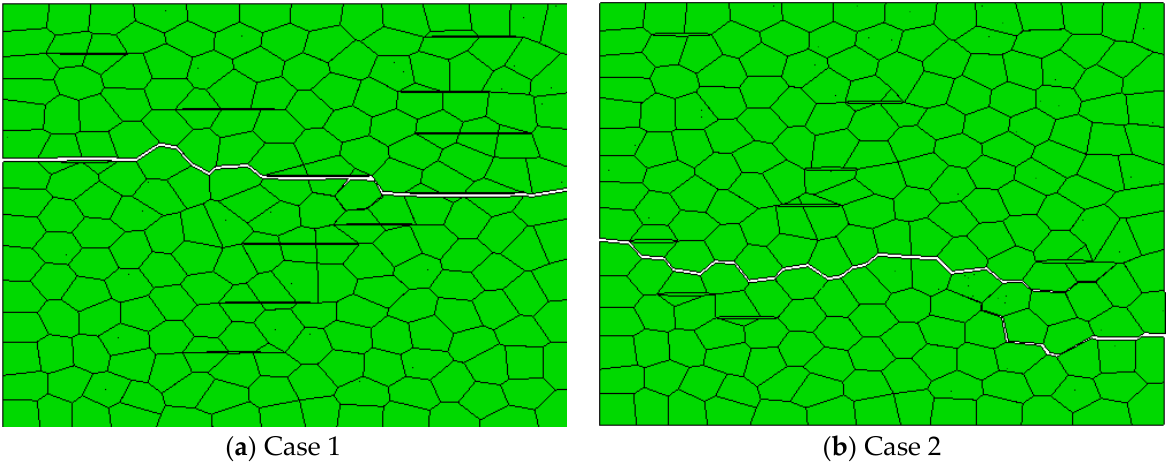
Figure 4. The simulation results of crack propagation when the volume content of graphene is 0.50 vol.%. Table 6. The calculation results of crack propagation under different graphene volume contents. The Volume Content of Graphene